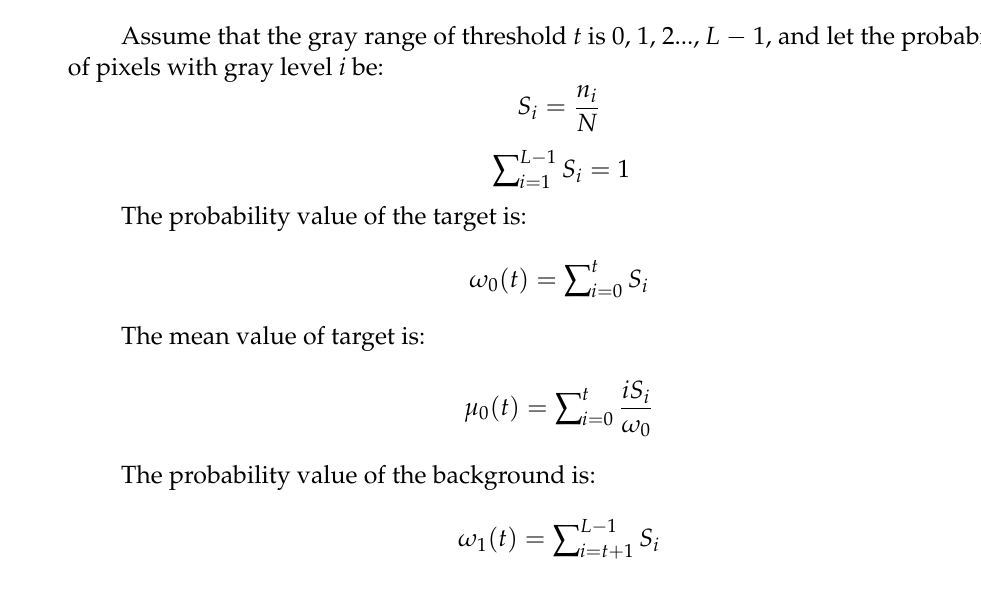
Figure 4. ( a ) presents the image of histogram equalization effect and ( b ) shows gray histogram image of freight track.